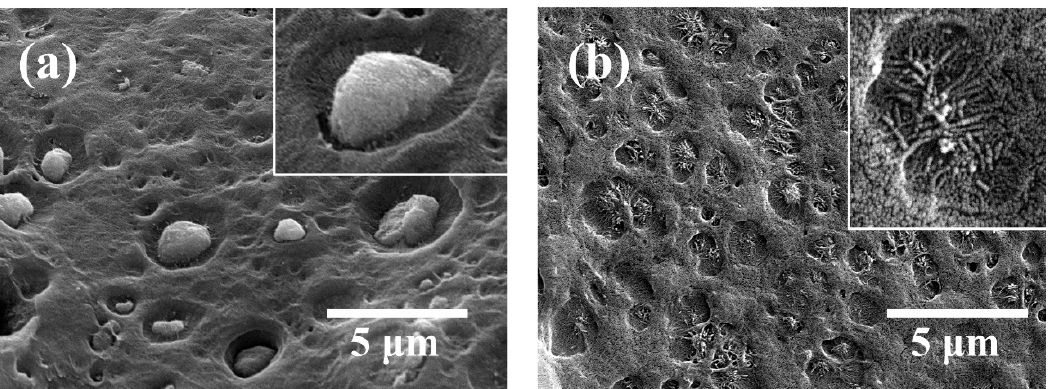
Figure 2. SEM images of cryo-fractured surfaces of electron-irradiated BA/HDPE ( a ) and vBA/HDPE ( b ). The insets are magnified images of the cavities formed.